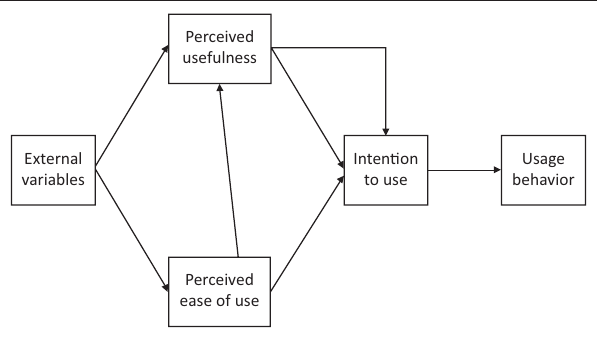
FIGURE 1: Technology Acceptance Model